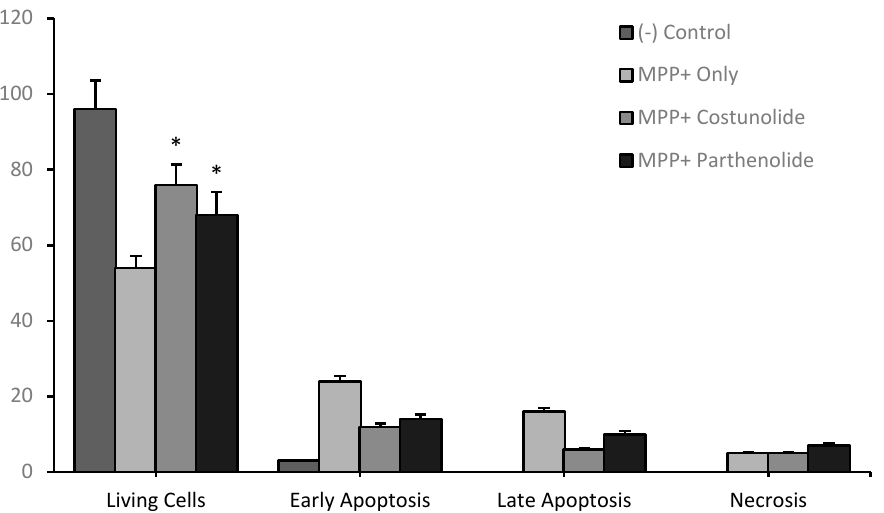
Figure 12. Flow cytometry analysis of costunolide and parthenolide applications (100 µg/mL) in the cellular PD model. Statistical significance compared to the MPP+ only applied group was shown (*) p < 0.05. (GraphPad Prism ® version 7.0, Two-way ANOVA and Tukey’s post hoc test were used to compare the means of different treatments to determine significant difference ( p < 0.05)).